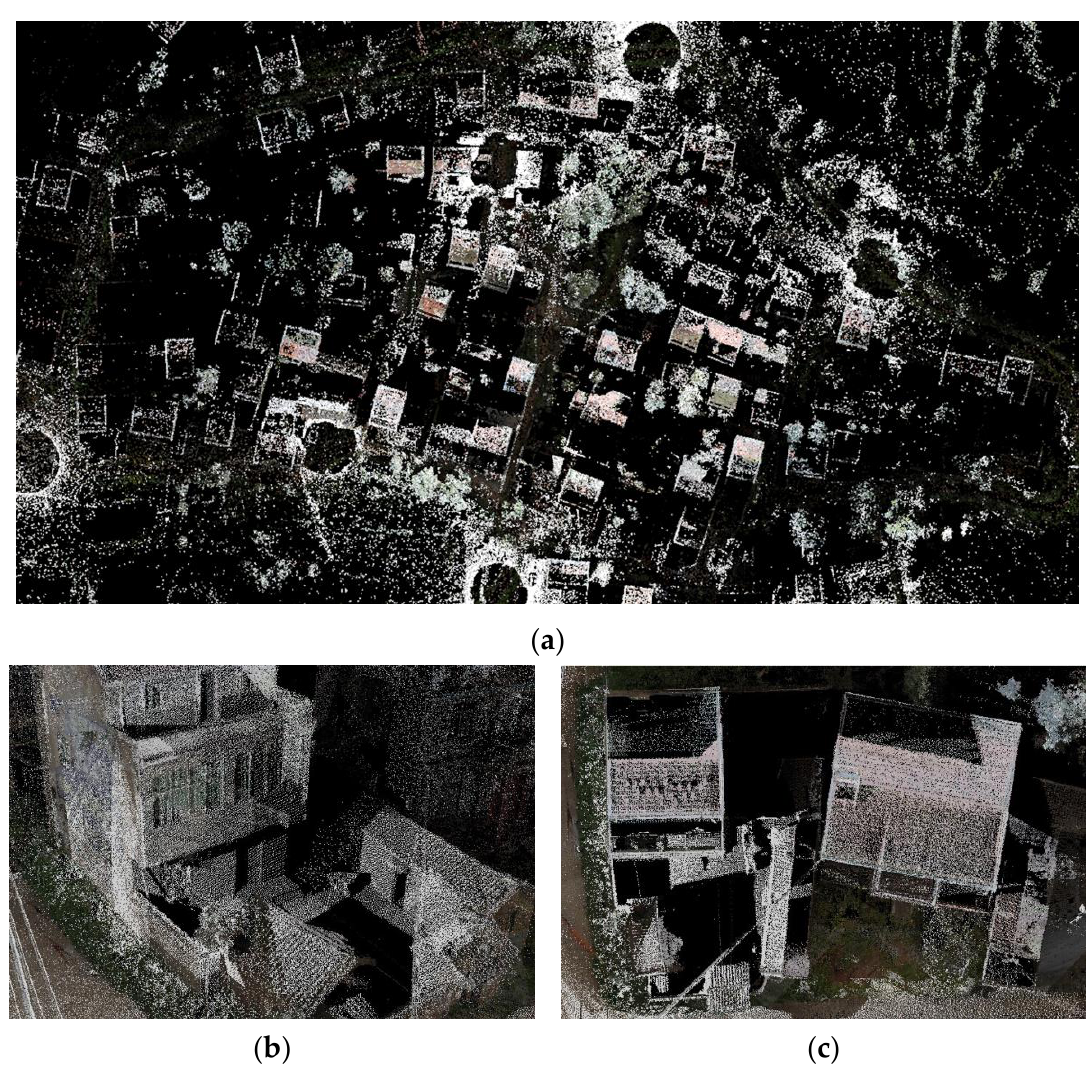
Figure 6. The fused dataset: ( a ) the dataset fused from the stop-and-go and electro-tricycle SSW systems; ( b ) a close-up view of a house with details; and ( c ) a close-up view of houses with details.